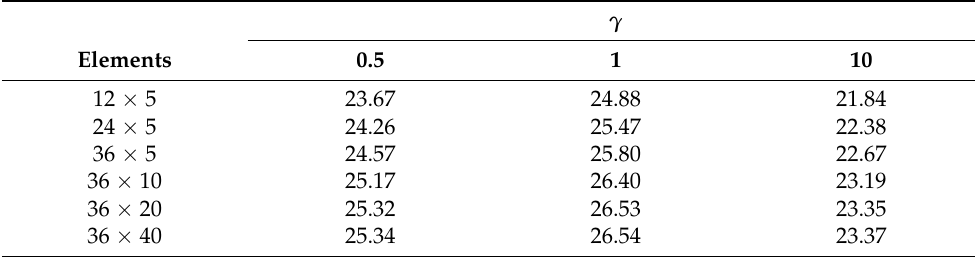
Table 3. Convergence of the fundamental frequency (Hz) of clamped-free FGM cylinders with number of finite elements.